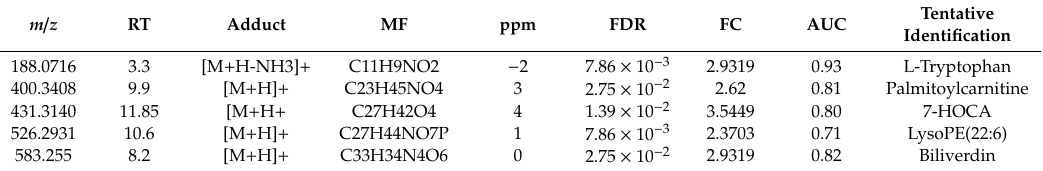
Table 1. Detailed information on the potential biomarkers to distinguish between T3cDM and T2DM.